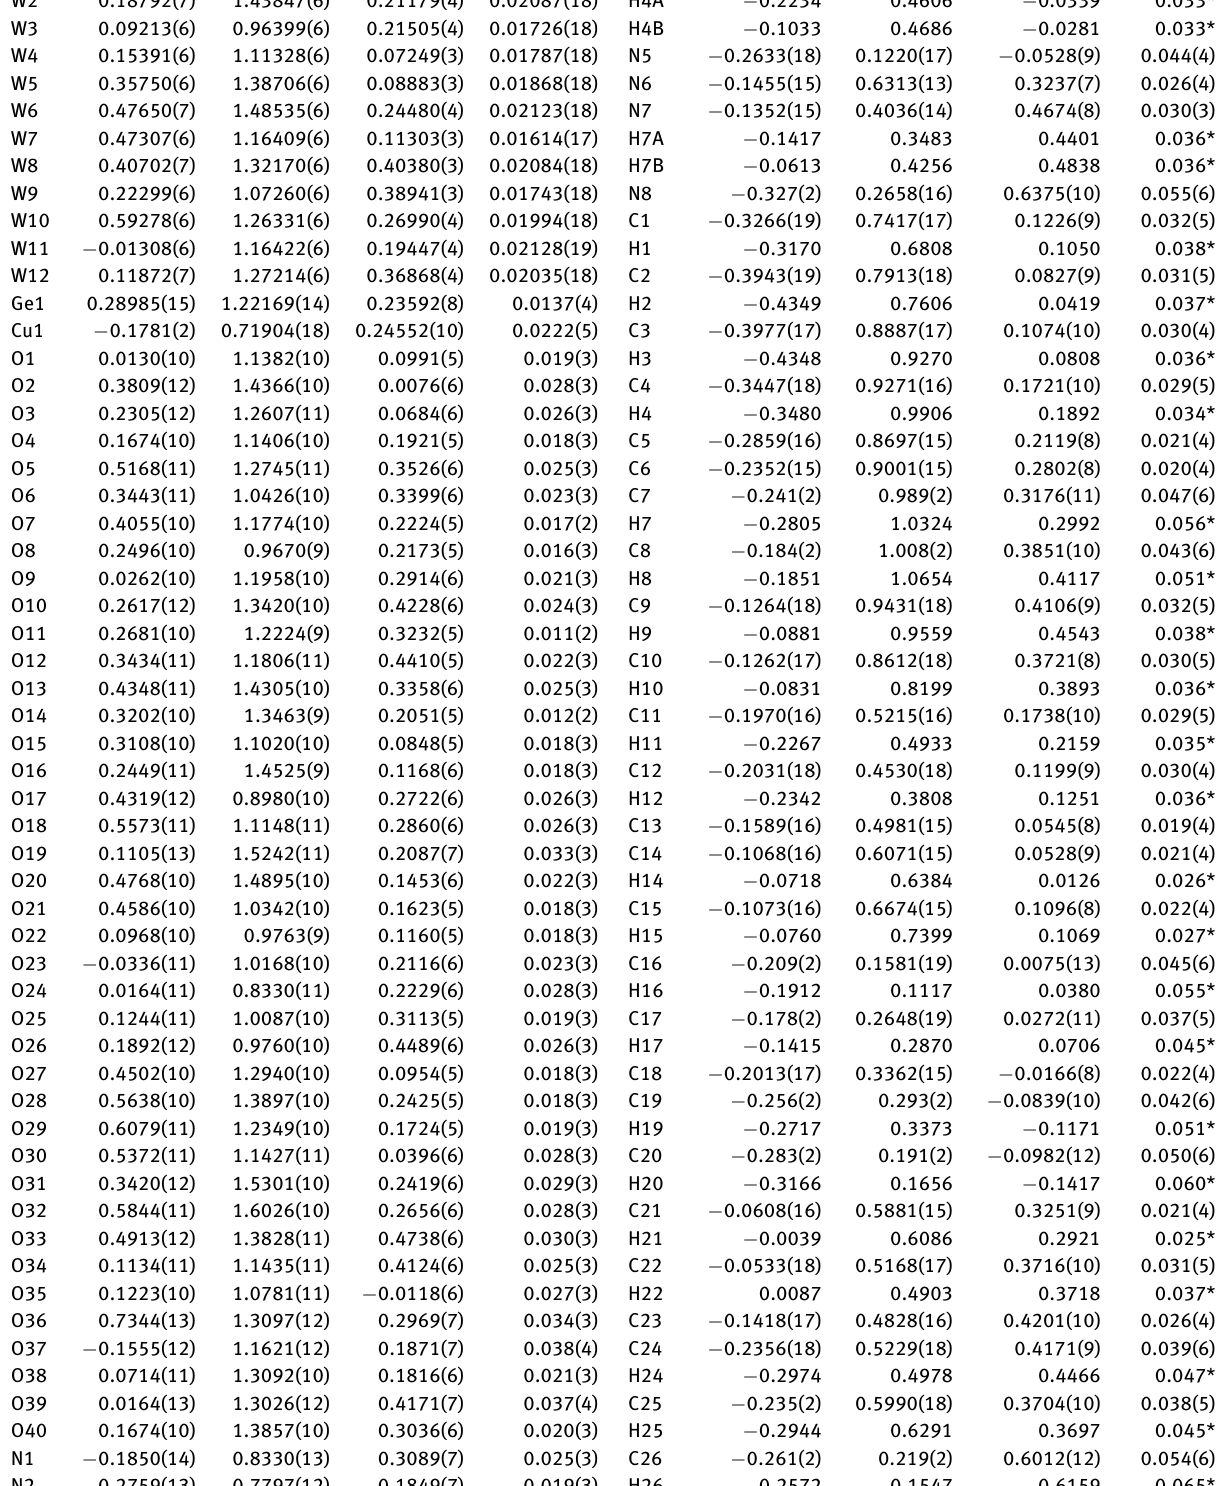
Table 2: Fractional atomic coordinates and isotropic or equivalent isotropic displacement parameters (Å 2